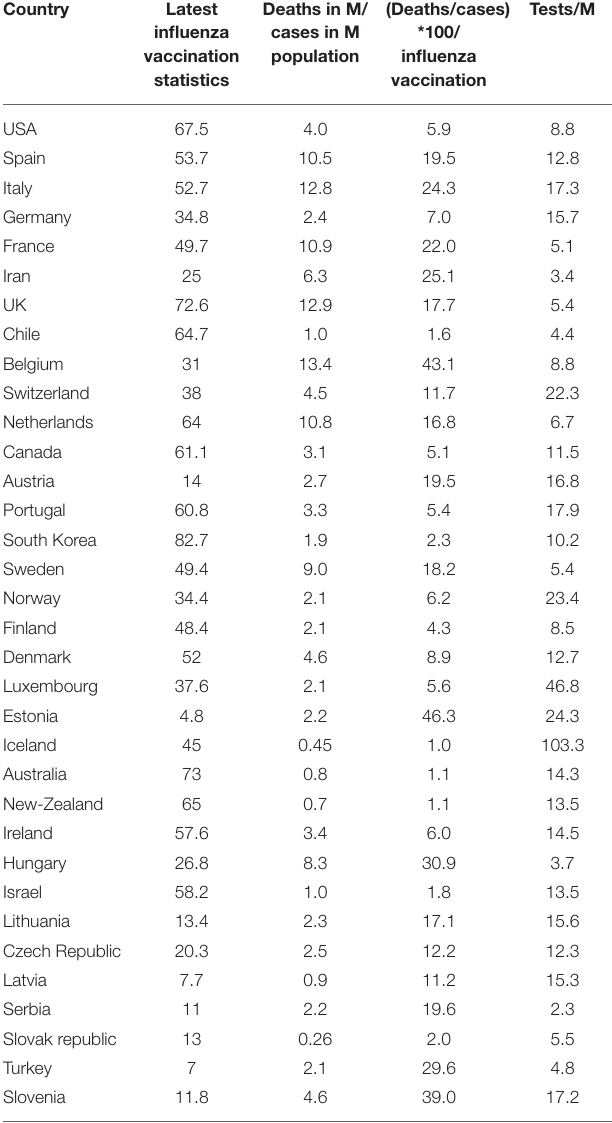
TABLE 2 | Death/million population and tests performed/million population (Data April 14, 2020).